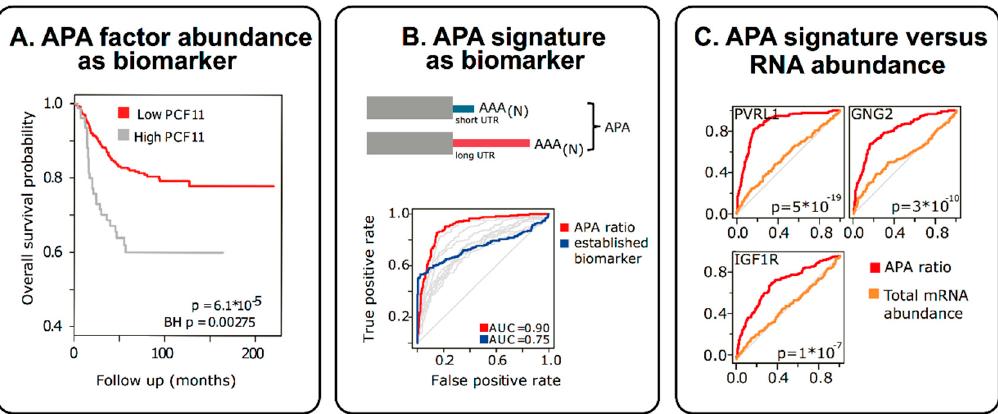
Figure 4. APA signatures are potent biomarkers (example shown for neuroblastomas). ( A ) High level PCF11 associates with lower survival probability. ( B ) PCF11-directed APA changes (APA ratio) represent potent prognostic biomakers (a current commonly used biomarker is shown in blue). In contrast, mere mRNA abundance changes of APA-affected targets (e.g., PVRL1, GNP2 or IGF1R) do not possess diagnostic potential ( C ). Thus, even genes with previously identified insignificant RNA abundance changes may possess strong diagnostic potential when qualitative aspects (APA ratio reflecting different transcript isoforms) are considered.